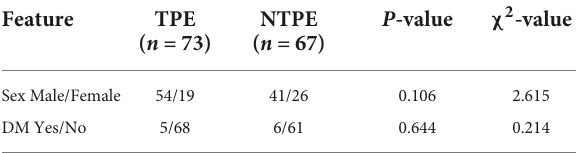
TABLE 3 The clinical features of TPE patients and Non-TPE